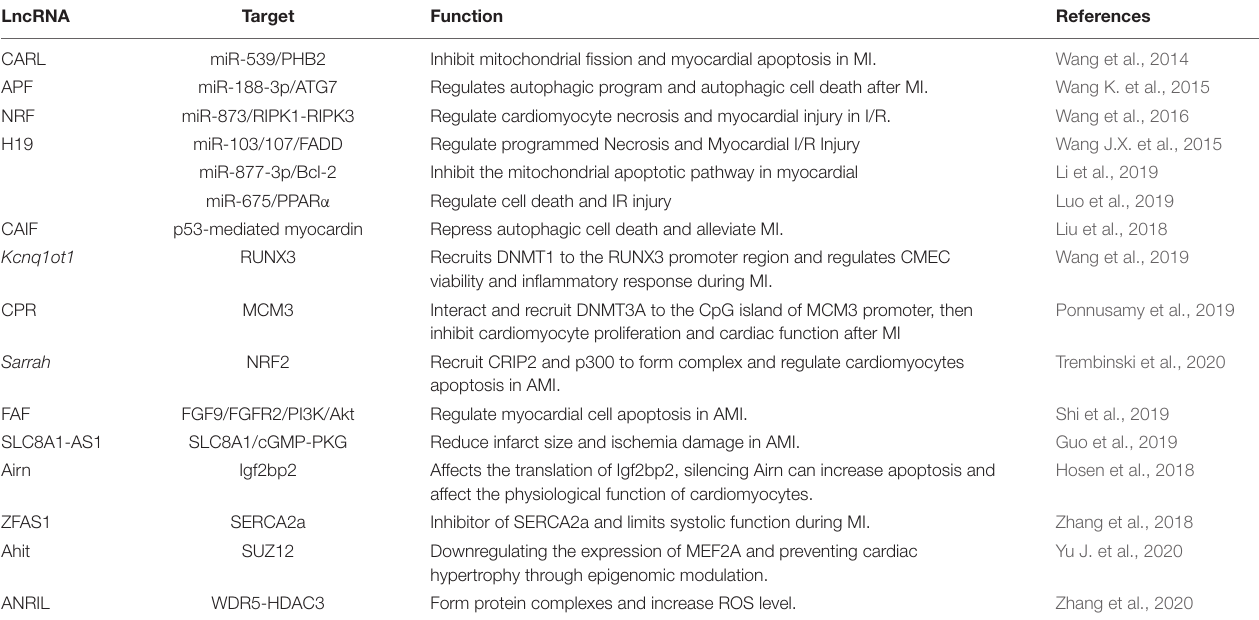
TABLE 1 | LncRNAs with characterized functions and target genes in myocardial infarction.